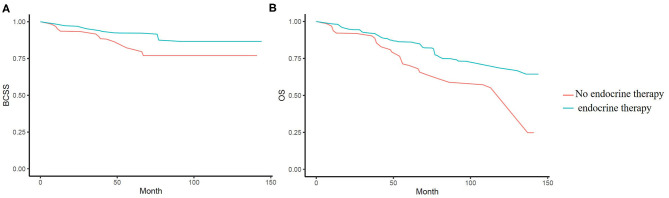
(A) Kaplan-Meier analyses of the effect of endocrine therapy on breast cancer specific survival (BCSS) in weighted samples. (B) Kaplan-Meier analyses of the effect of endocrine therapy on overall survival (OS) in weighted samples.